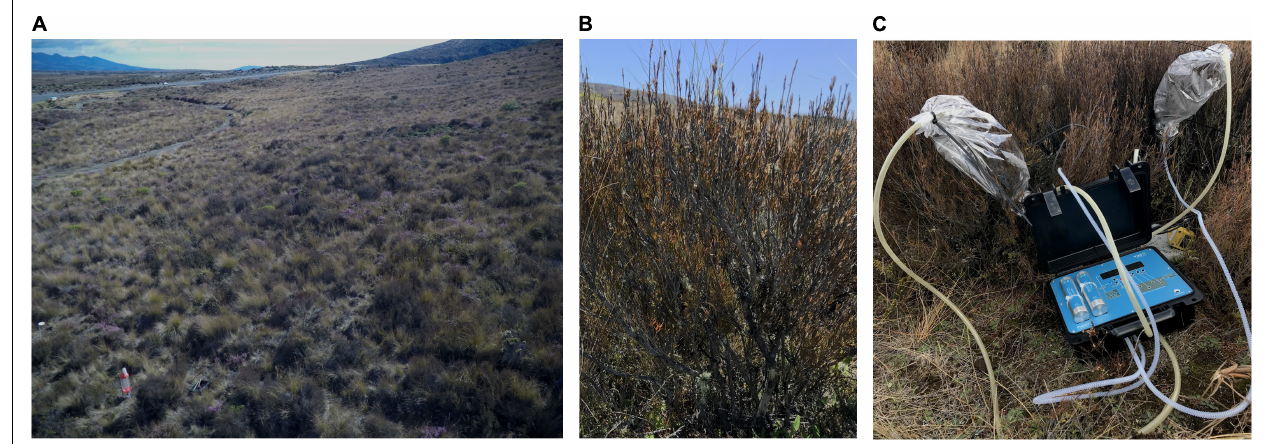
FIGURE 1 | Images of part of the sampling location (A) , Dracophyllum subulatum plant (B) , and volatile collection procedure (C)